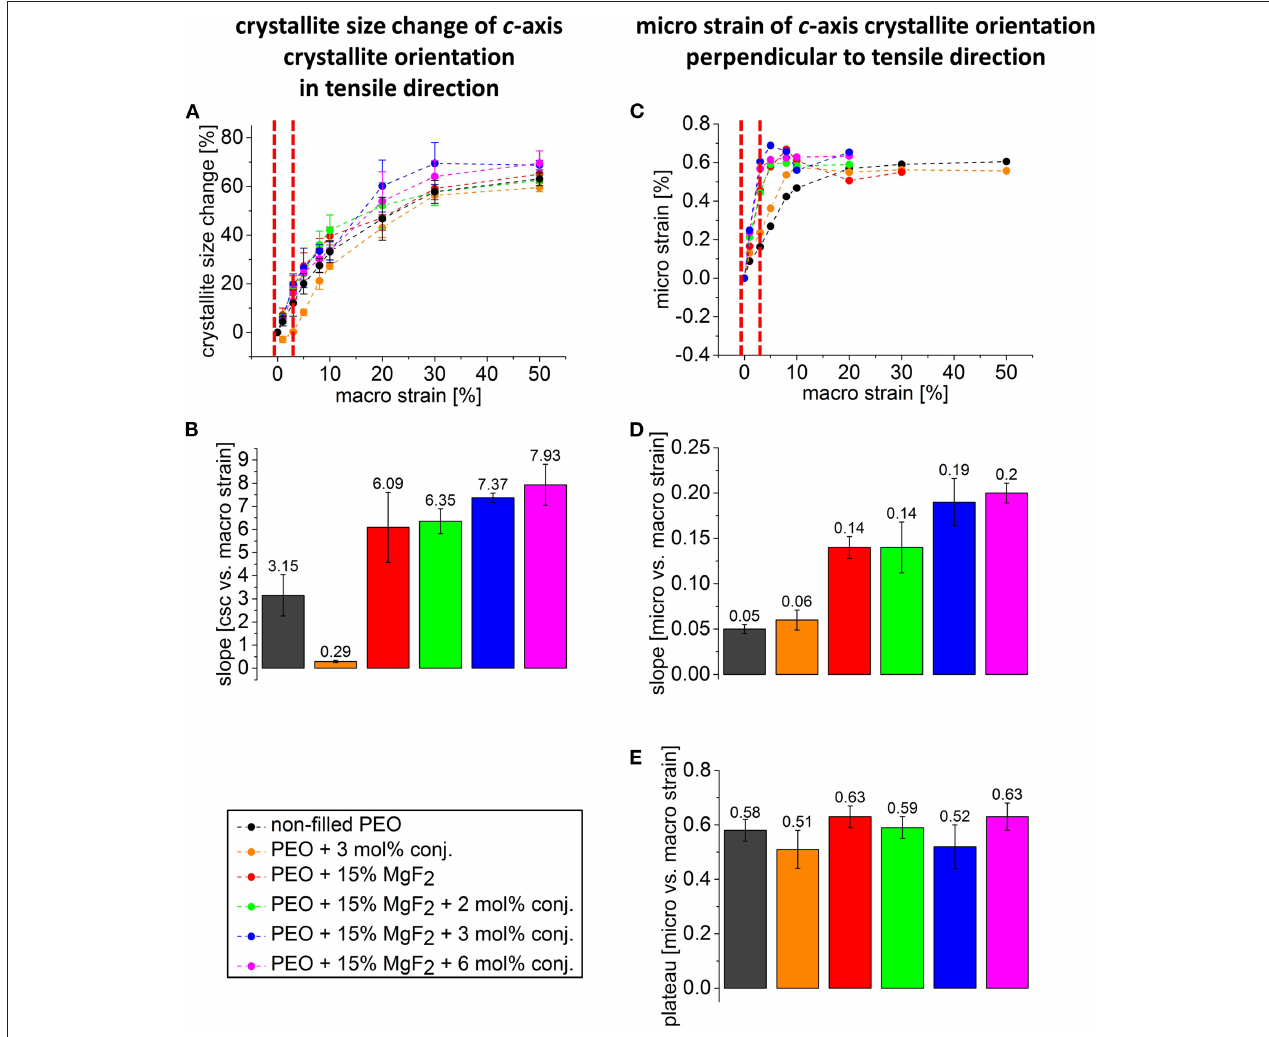
FIGURE 6 | Percentage crystallite size change (A) of the crystallites with the c-axis aligned in tensile direction. The slope was determined within the elastic range (red bars) and drawn as bar charts (B) with corresponding standard deviation for n = 3 samples. An increase of the values can be observed after the insertion of MgF 2 compatibilized by the peptide-PEG conjugate and therefore, a faster decrease of the crystallite sizes during applied tensile stress. Also the slope of micro vs. macro strain (C) within the elastic range (red bars) of the crystallites with the c-axis aligned perpendicular to the tensile direction was determined. The results were drawn as bar charts (D) as well as the plateau values (E) for n = 3 samples. Again an increase after insertion of compatibilized MgF 2 could be observed for the slope values, whereas the plateau values stayed in the same range for all sample